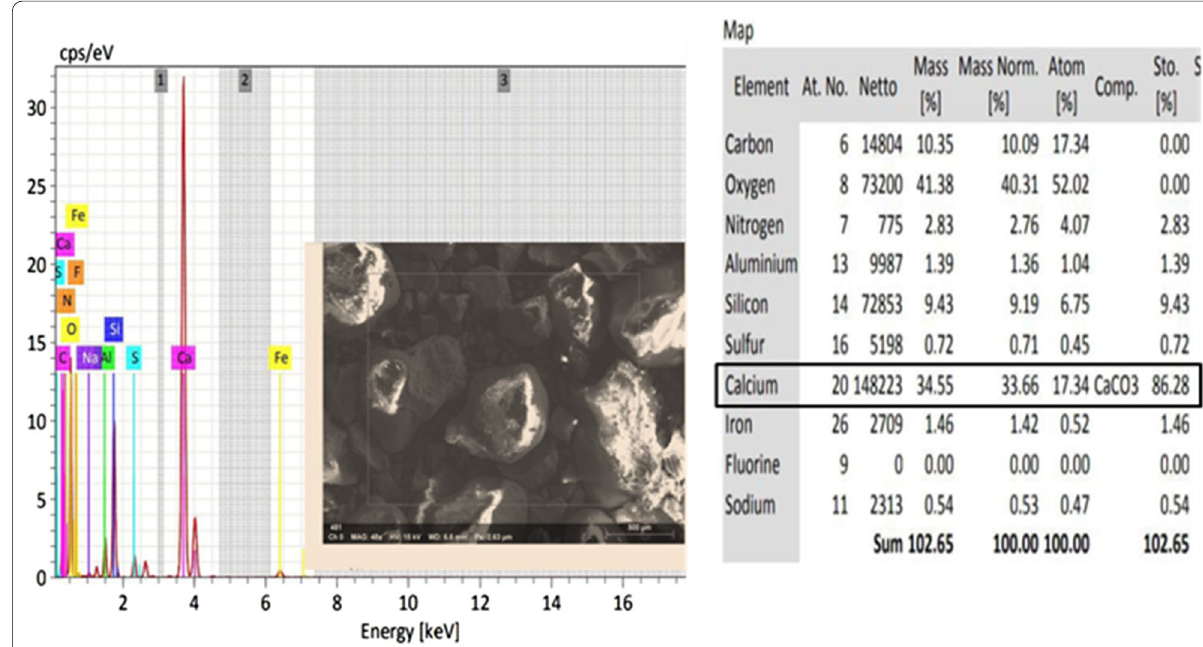
Fig. 6 Energy dispersive X‑ray analysis (EDX) of precipitated calcite in concrete of B1 ( Bacillus wiedmannii ) bacterial spores